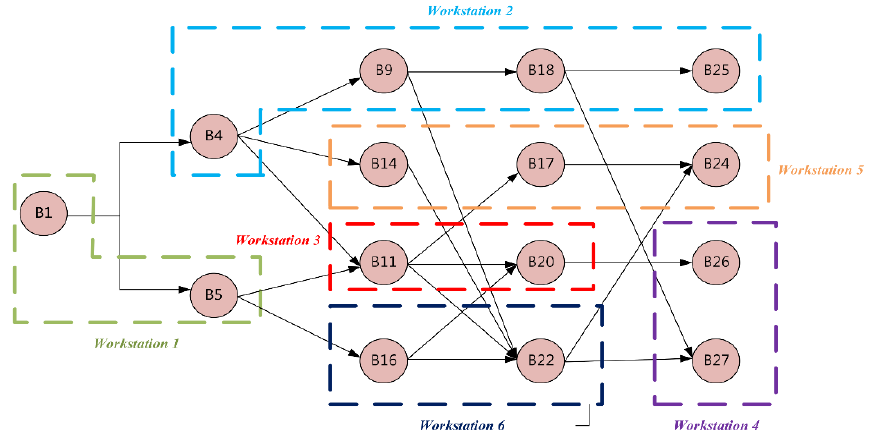
Figure 6. An example of the DLBP.